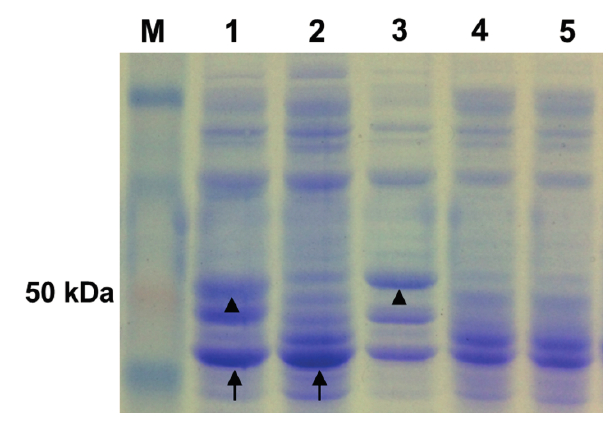
Figure 4. The extracellular supernatant proteins of Lactobacillus reuteri transformants were analyzed by SDS-PAGE. Lane 1 , L. reuteri XC1; Lane 2 , L. reuteri pLEM4156; Lane 3 , L. reuteri pLEM4157 (cel); Lane 4 , L. reuteri pLEM4158 (phy); Lane 5 , L. reuteri pLEM4159-cel/phy; Lane M , molecular weight marker. Black triangle: protein band of celW ; and Black arrow: protein band of phyWM .